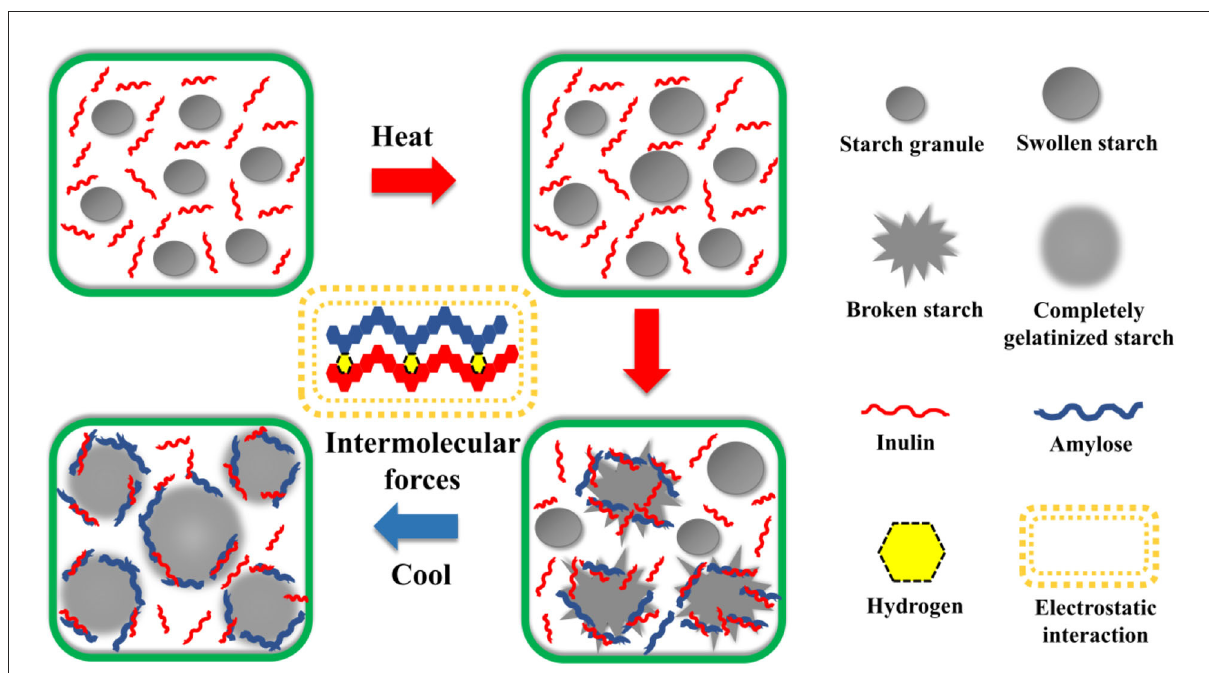
FIGURE4 Potential schematics for the mechanism of interaction between starch and